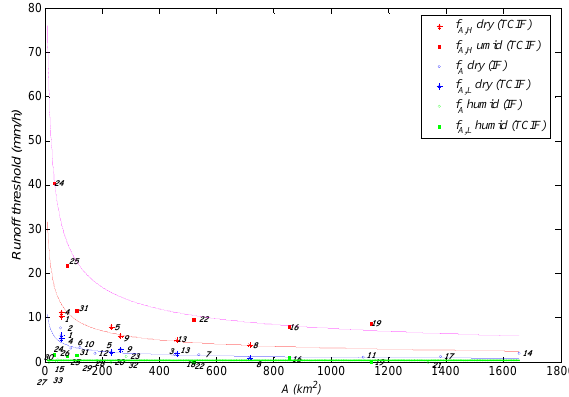
Figure 3. Regional scaling of different runoff thresholds. Fig. 3. Regional scaling of different runoff